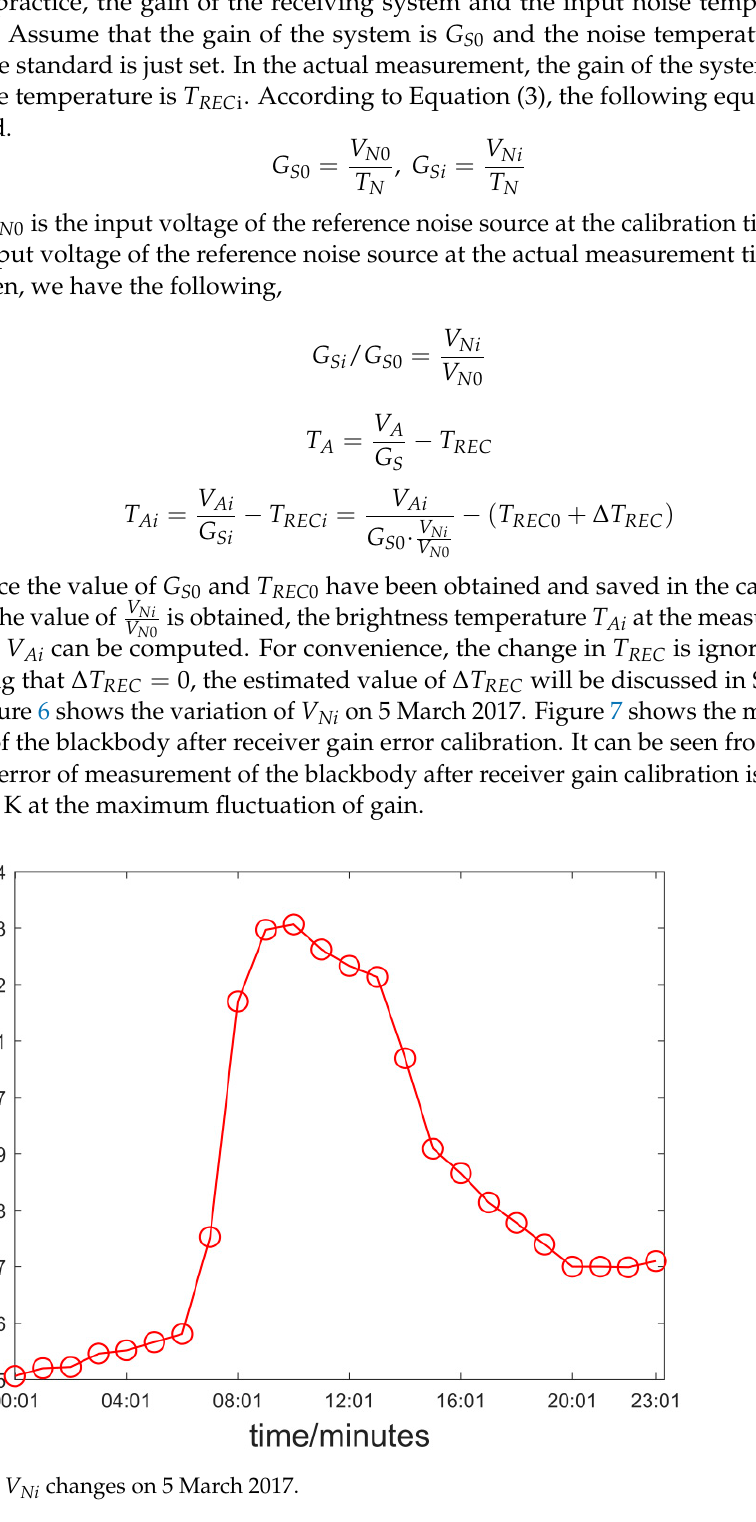
Figure 6. V Ni changes on 5 March 2017.